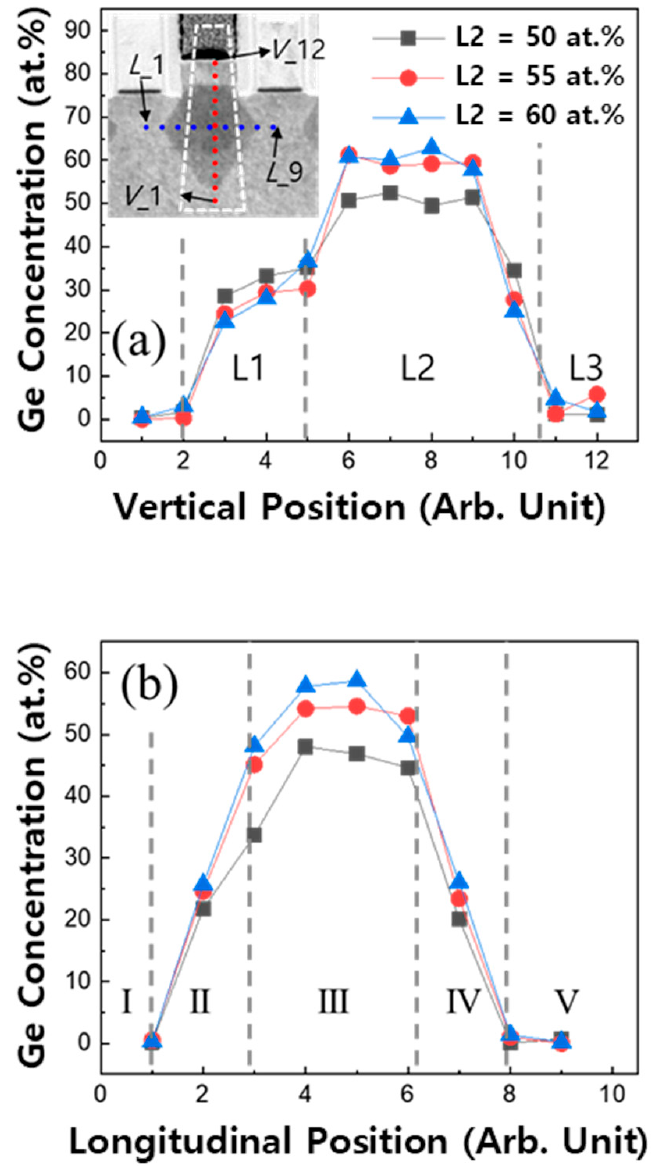
Figure 2. C Ge distribution for ( a ) vertical and ( b ) longitudinal direction of C Ge = 50, 55, and 60 at.% in SiGe of L2.